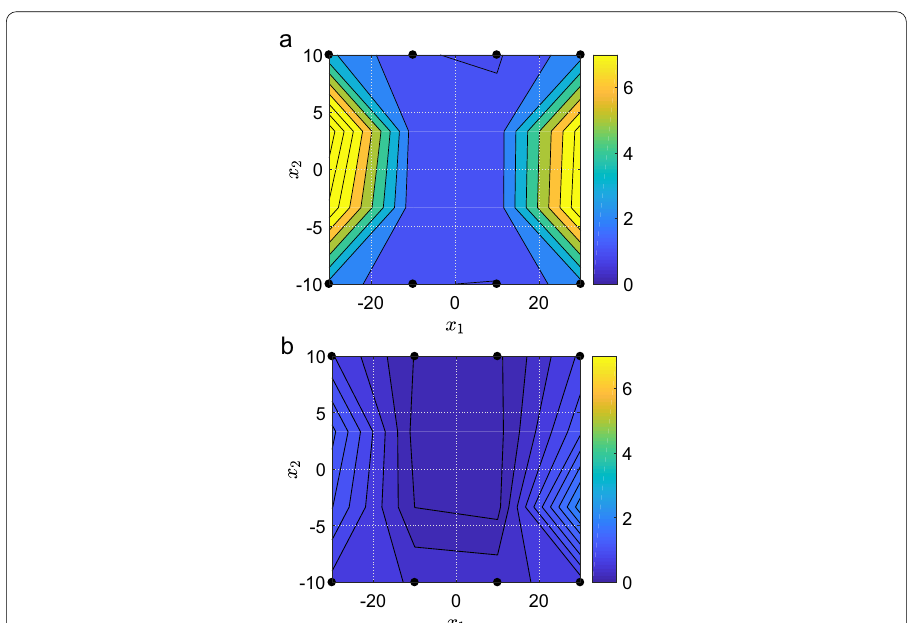
Fig. 6 Performance in T doa across space. Root-mean square error in (m) with respect to different locations x 0 . Results based on 50 Monte Carlo runs. a Corresponds to standard E rm (8) and b corresponds to the proposed method (12)